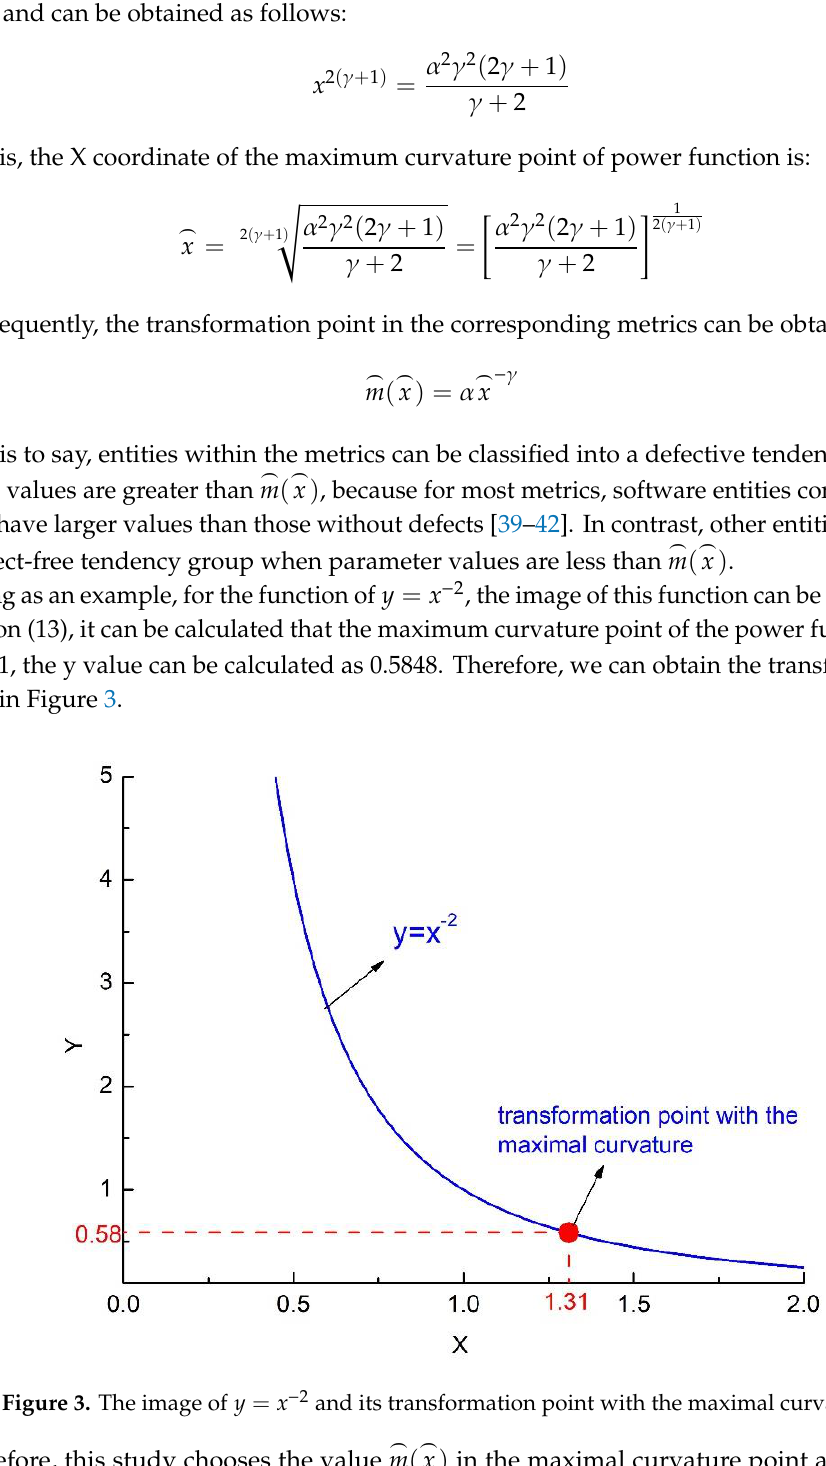
Algorithm 1. Software defect prediction based on power-law function Input D